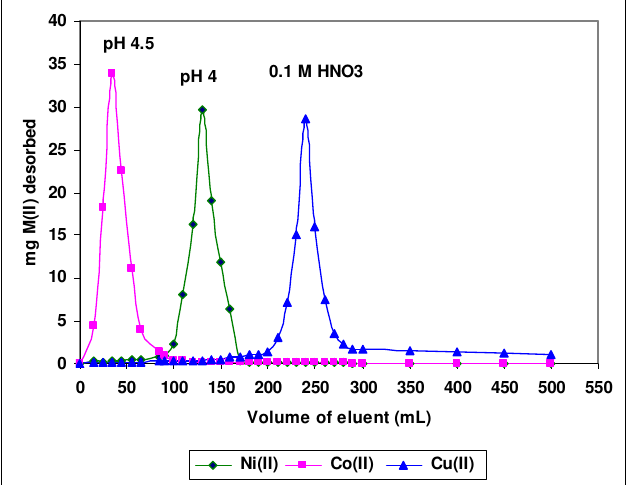
Figure 4 . Separation of a mixture of Co(II), Ni(II) and Cu(II), (5.0 g of ligand system, flow rate 1.0 -1.5 cm 3 min -1 , pH = 5.5, Total eluent volume = 500 cm 3